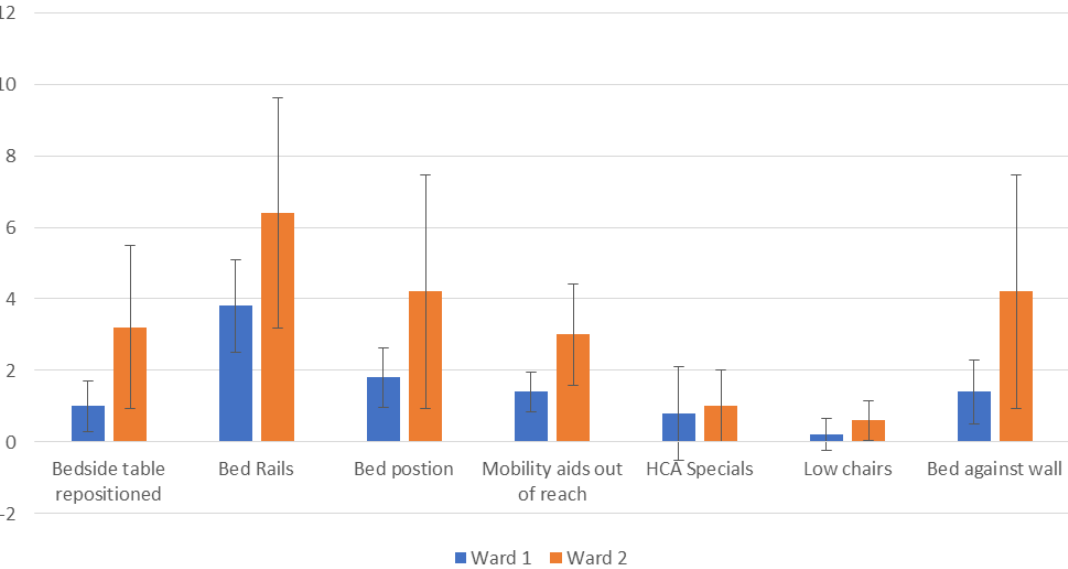
Table 1. Examples of direct and indirect restraint used in clinical practice.